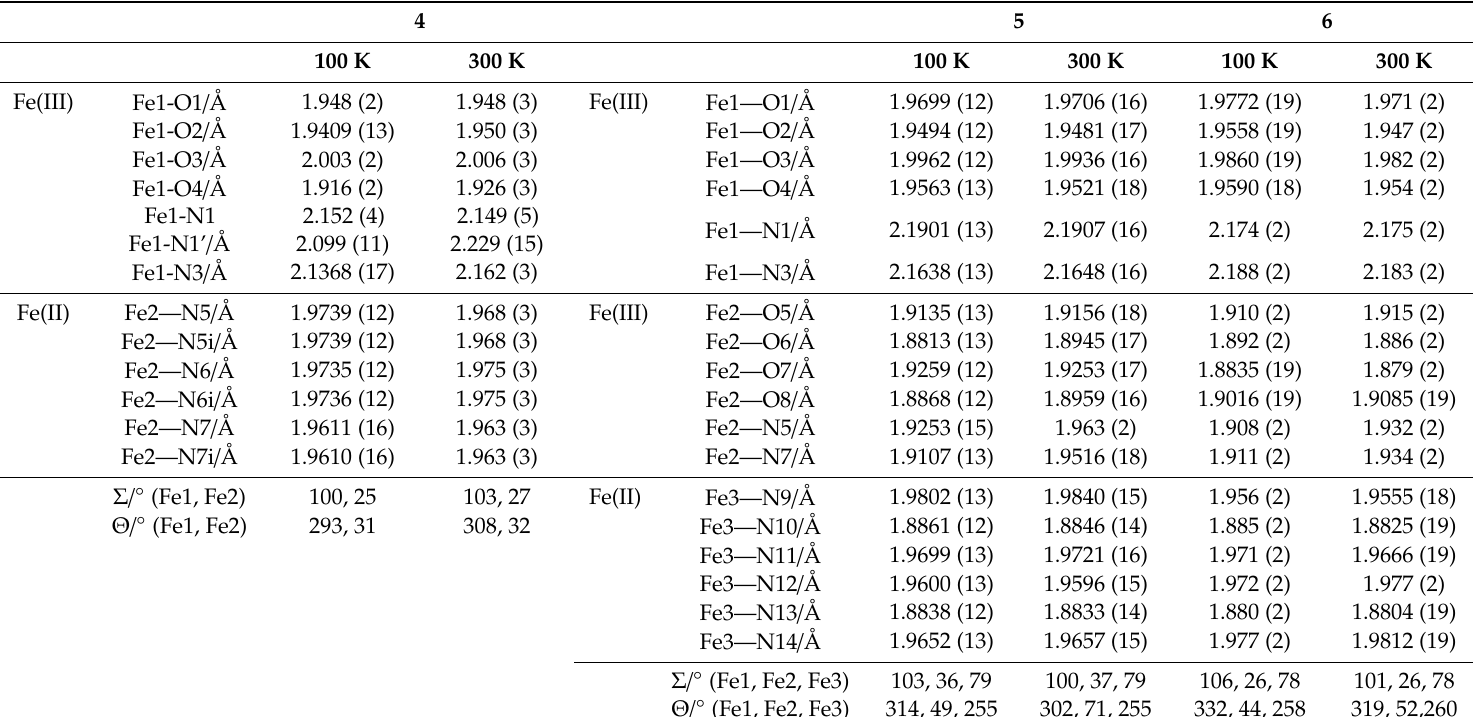
Table 2. Selected bond lengths and octahedral distortion parameters for 4 – 6